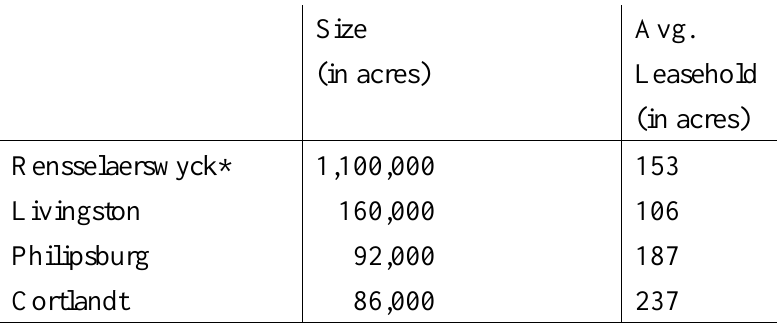
Table 4: Manor Size & Average